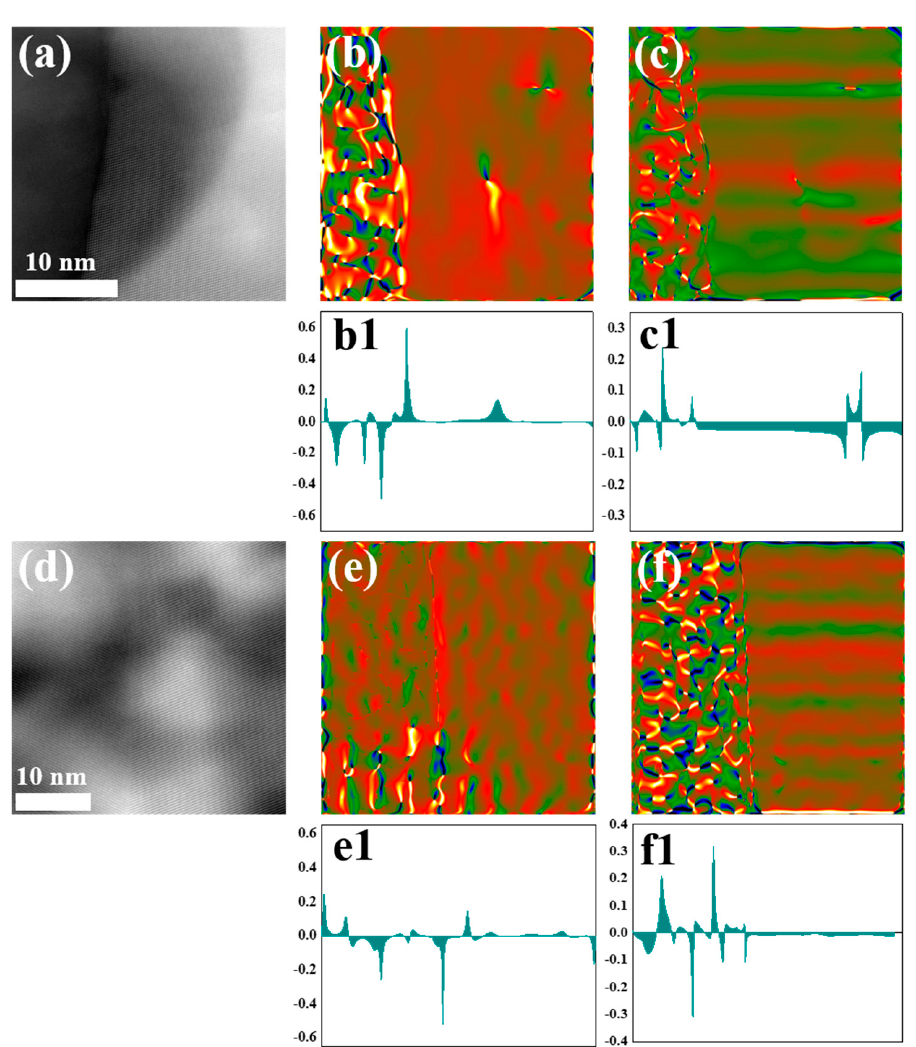
Figure 6. HRSTEM images of the Ag-SnO 2 interface ( a ) and Ag-La 2 Sn 2 O 7 interface ( d ); strain map- ping at the Ag-SnO 2 interface in the x direction ( ε xx , ( b )) and y direction ( ε yy , ( c )) and corresponding strain-distance curves (( b1 , c1 ); strain mapping at the Ag-La 2 Sn 2 O 7 interface in the x direction ( ε xx , ( e )) and y direction ( ε yy , ( f )) and corresponding strain–distance curves (( e1 , f1 ). (red and blue in strain mapping indicate large strain in different directions, while the green indicate a area free from strain)